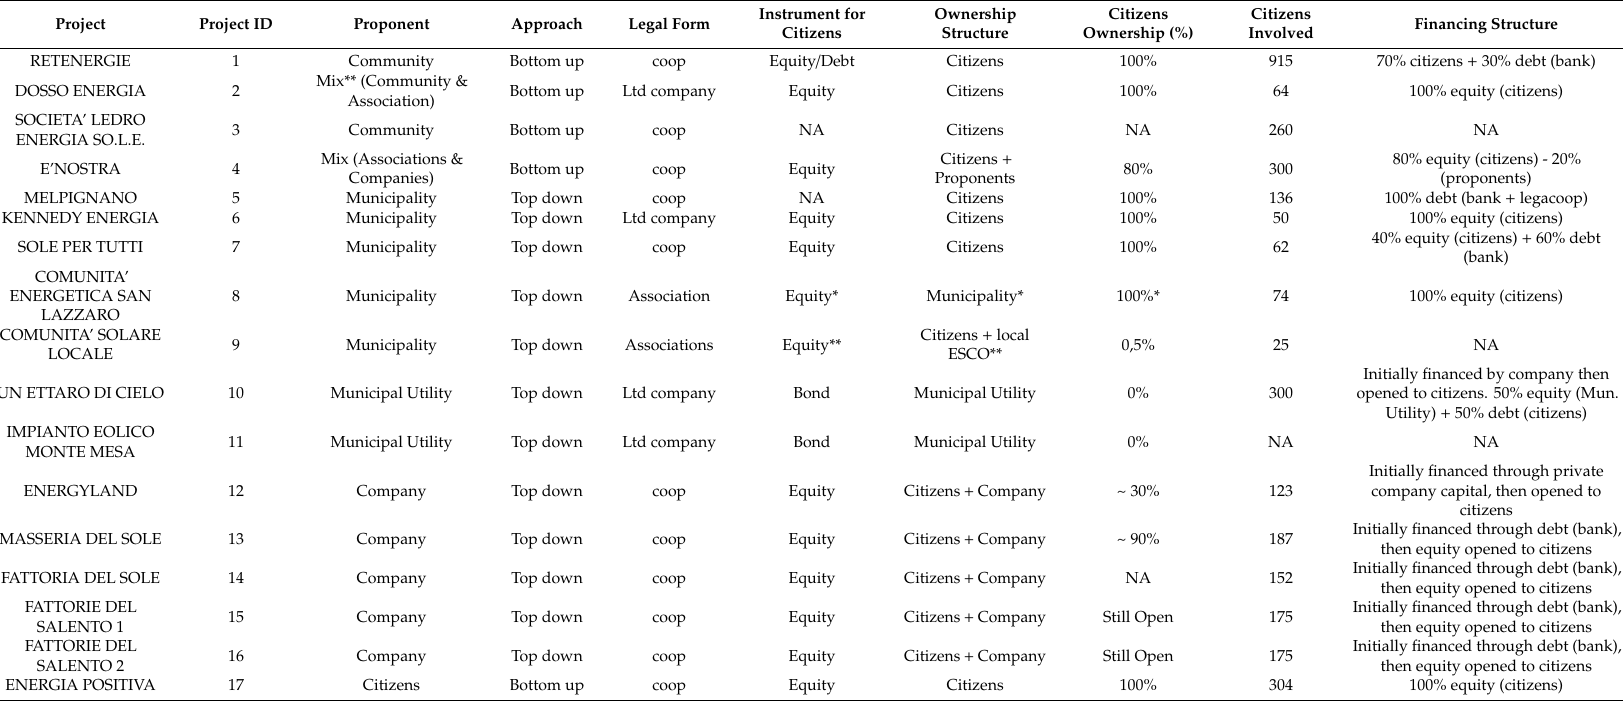
Table A1. Dynamics of creation and organizational